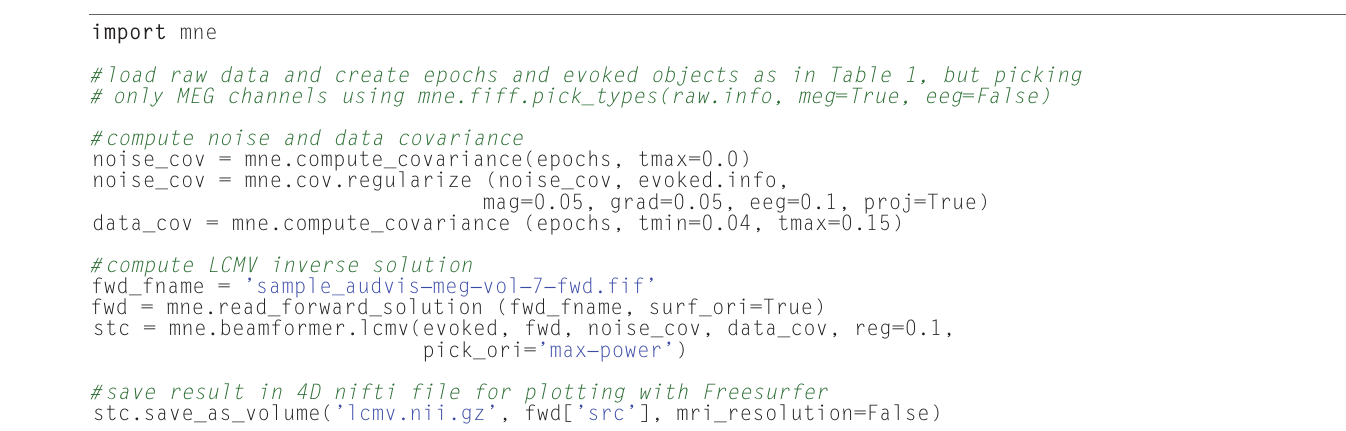
Table 5 | Inverse modeling using the LCMV